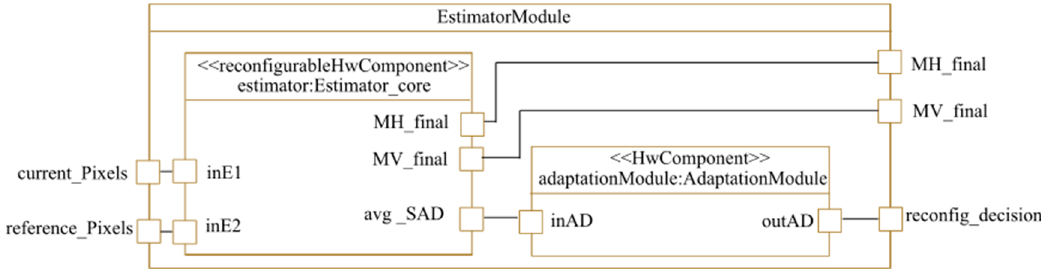
Figure 10. Estimator modeling.